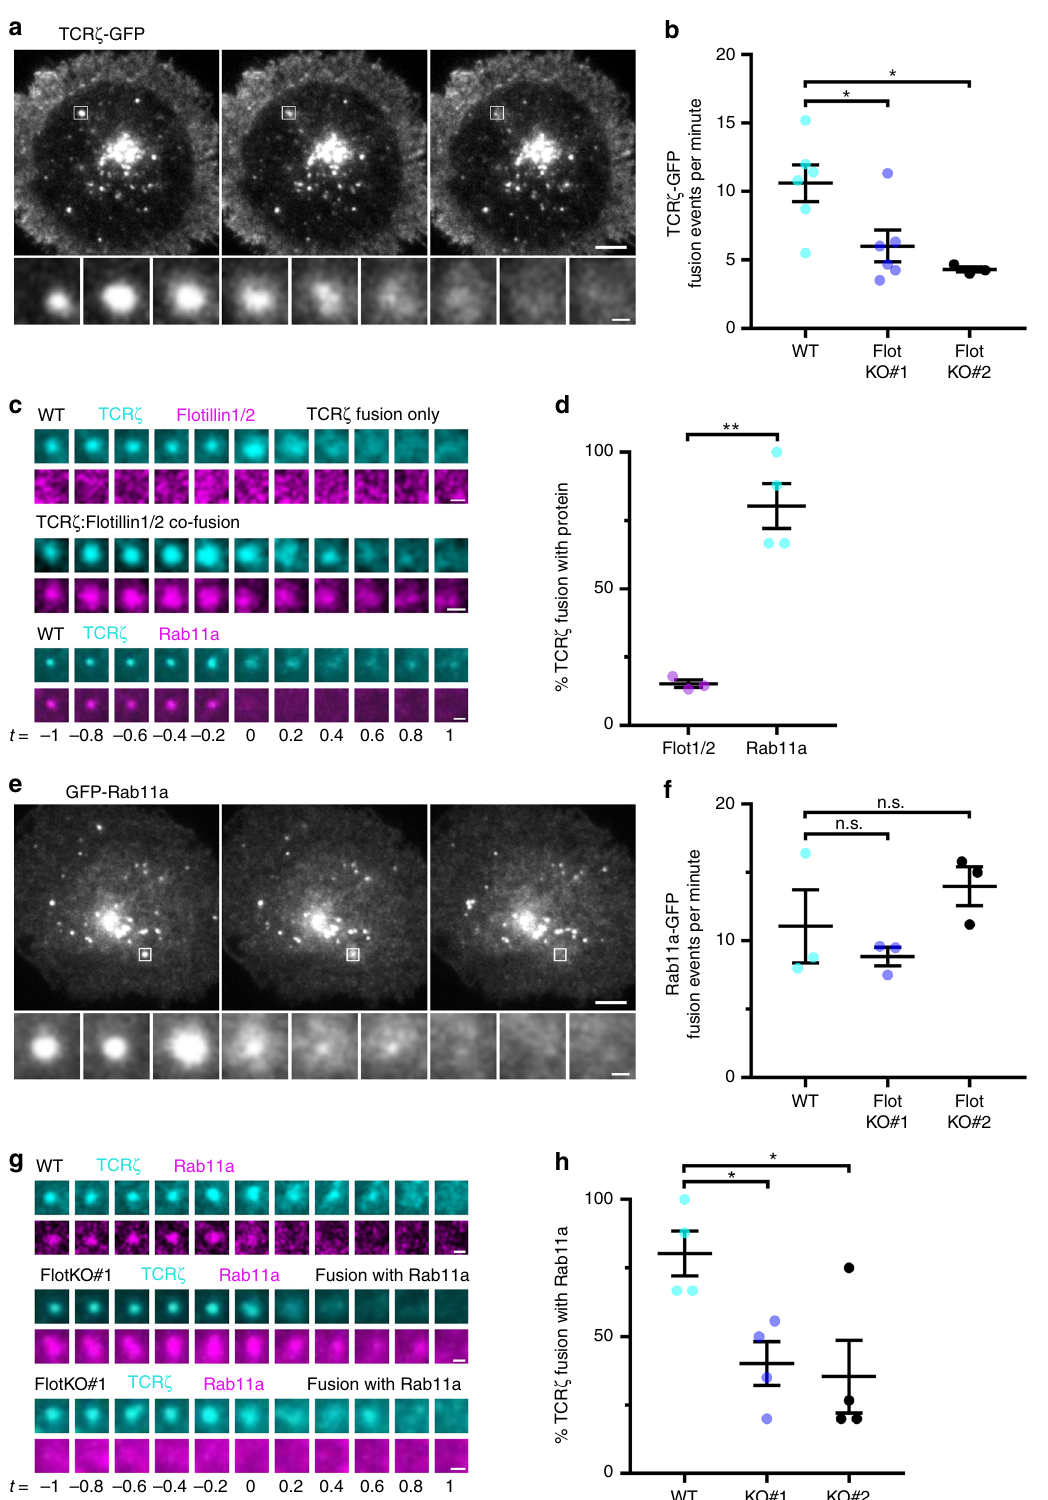
within endosomes to investigate if the spatial organisation of Rab11a endosomes supported the sorting of TCR ζ for a return to the plasma membrane (Fig. 5a). Upon exposure to blue light, Cry2clust oligomerises, binding CIB1-tagged proteins to form large multimers 48 . Blue light-induced clustering of CIB1-Rab11a resulted in signi fi cantly less (Supplementary Fig. 4a, b) and more intense (Supplementary Fig. 4c, d) CIB1-Rab11a